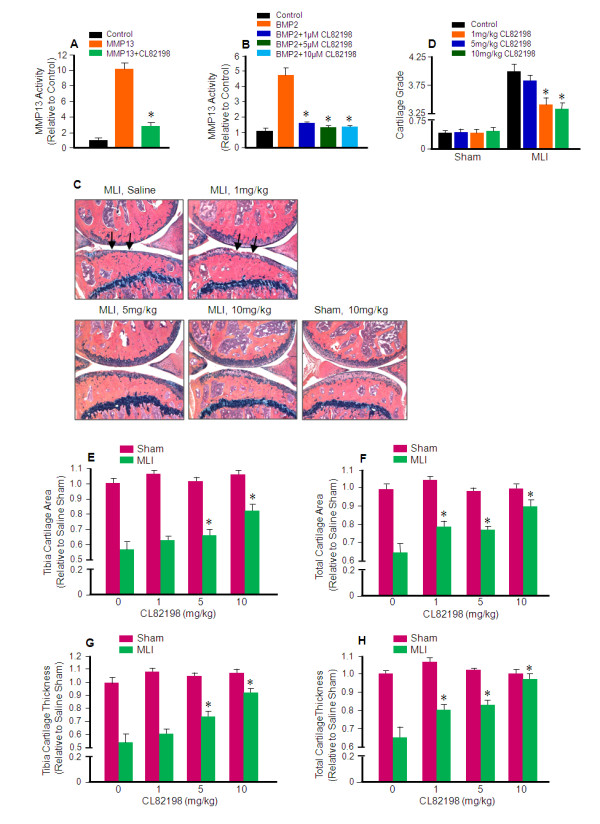
CL82198 prevents and decelerates MLI-induced osteoarthritis progression. (A and B) CL82198 inhibits matrix metalloproteinase (MMP13) activity in vitro. (A) Addition of 5 ng of MMP13, 5 ng of MMP13 and 10 μg/mL of CL82198, or substrate control into a 96-well plate. MMP13 enzyme activity was determined using the SensoLyte 520 MMP13 Assay Kit, and showed that CL82198 could block > 90% MMP13 activity in vitro. (B) Primary sternal chondrocytes were isolated from three-day-old wild type pups. Cells were plated in 12-well plates and treated with 100 ng bone morphogenetic protein 2 (BMP-2), 100 ng of BMP-2 and 1 μM of CL82198, 100 ng of BMP-2 and 5 μM of CL82198, 100 ng of BMP-2 and 10 μM of CL82198, or vehicle control for 60 hours. Cell culture media was collected and MMP13 activity was determined and showed that CL82198 could inhibit > 90% MMP13 activity produced by BMP-2-treated primary chondrocytes. (C) Inhibition of MMP13 by CL82198 protects against meniscal-ligamentous injury (MLI)-induced osteoarthritis (OA). MLI and sham surgeries were performed on 10-week-old wild type mice. CL82198 was administered to wild type mice one day after surgery by intraperitoneal injection every other day for 12 weeks at doses of 1, 5, or 10 mg/kg body weight. Normal saline was used as a control. Knee joints were collected, and sectioned 12 weeks post-surgery, and Alcian blue/Hematoxylin/Organge G staining was performed. (D) Histological grading by two blinded observers confirmed decreased articular cartilage degradation in mice treated with 1, 5, and 10 mg/kg of CL82198 compared to saline control mice (*P < 0.001). (E) The articular cartilage area at proximal tibiae was quantified by tracing the Alcian blue-positive area in the proximal tibia. Compared to saline MLI, tibial cartilage area was increased 9, 15, and 43% after treatment with 1, 5, and 10 mg/kg of CL82198, respectively (*P < 0.05). (F) Total articular cartilage area was quantified by tracing the Alcian blue-positive area in both the proximal tibia and the distal femur. Total cartilage area was increased 21%, 19%, and 38% with treatment of 1, 5, and 10 mg/kg of CL82198, respectively (*P < 0.05). (G) Tibia cartilage thickness was quantified by tracing the Alcian blue-positive thickness in the center of the tibial plateau. Compared to saline treatment, tibia cartilage thickness was increased 11%, 37%, and 70% with treatment of 1, 5, and 10 mg/kg of CL82198, respectively (*P < 0.05). (H) Total thickness was quantified by tracing the Alcian blue-positive thickness in both the proximal tibia and the distal femur. Total cartilage thickness was increased 23%, 27%, and 50% after injection of 1, 5, or 10 mg/kg CL82198, respectively (*P < 0.05).